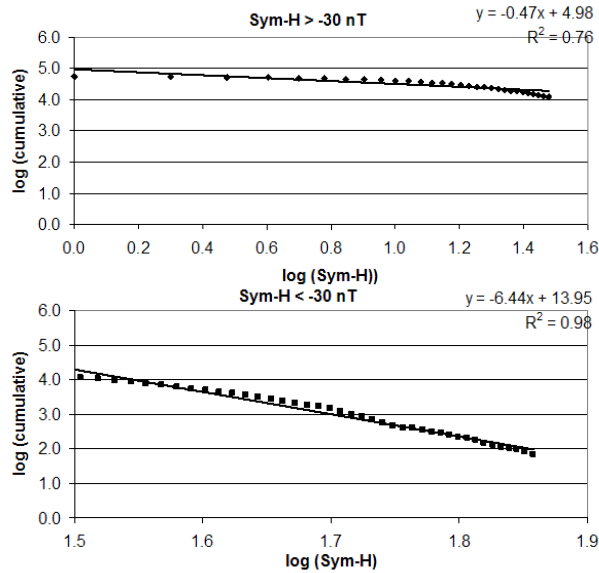
Fig. 5. Magnitude-frequency distribution for the AE index under 800nT (quiet – top) and over 800nT (bottom).